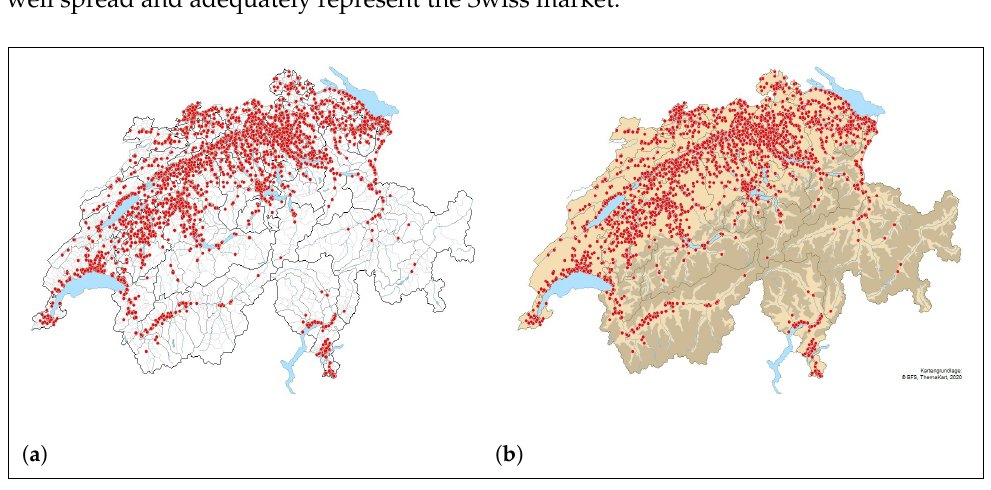
Figure 5. Map of flat rentals in Switzerland represented by the red dots. The first map represents all the Swiss cantons ( a ), while the second map with the same cantons ( b ) also shows infertile areas in dark